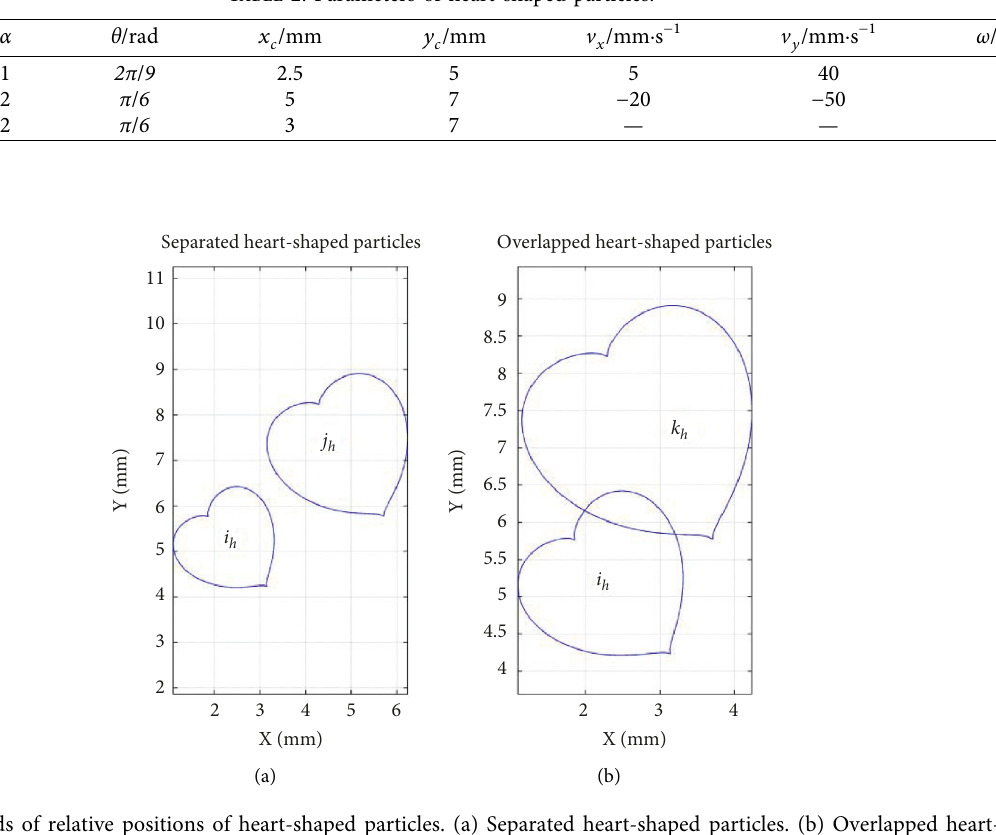
Table 2: Parameters of heart-shaped particles.